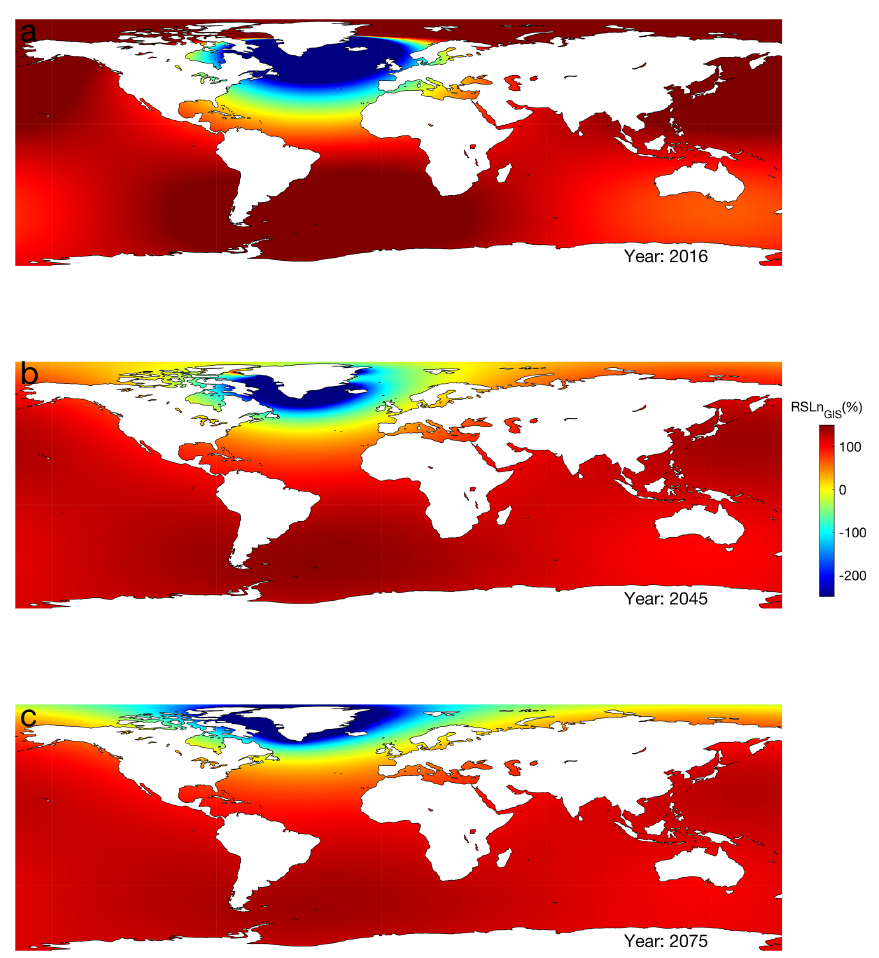
Figure 1. Normalized fingerprints for Greenland in (a) 2016, (b) 2045 and (c) 2075, based on the JPL ISSM experiment 5 simulation that contributed to ISMIP6 (Goelzer et al., 2020). The relative sea-level change patterns in the North Atlantic and Arctic oceans vary significantly in both space and time, resulting in very different contributions to local RSL in the years 2016, 2045 and